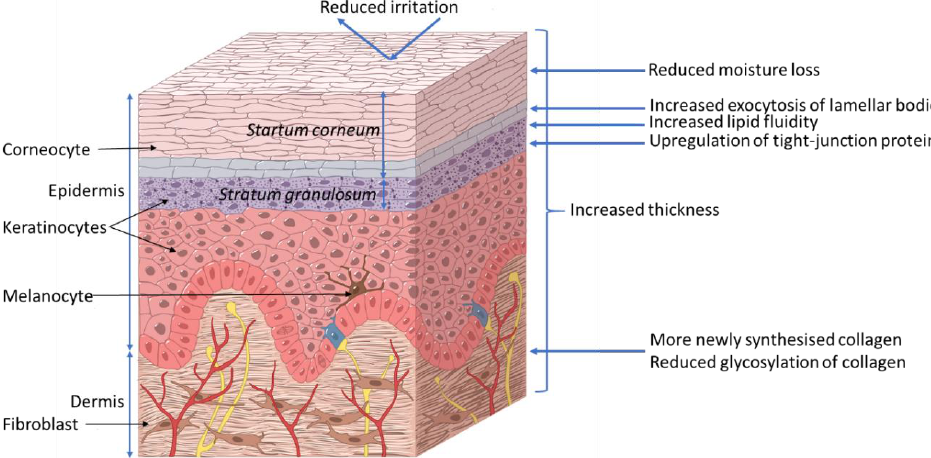
Figure 2. Proposed effects of xylitol on skin health. © DuPont Nutrition & Biosciences.